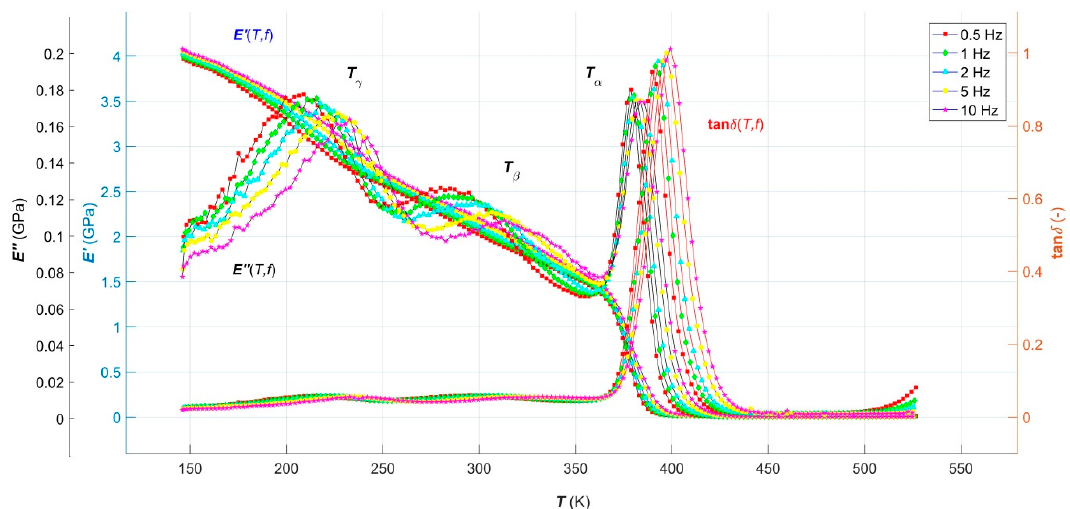
Figure 2. Temperature-frequency dependences of average storage modulus, loss modulus and loss tangent of TPU over the temperature range from 146 K to 527 K at constant strain rate of 0.1 Hz and frequencies of 0.5 Hz, 1 Hz, 2 Hz, 5 Hz and 10